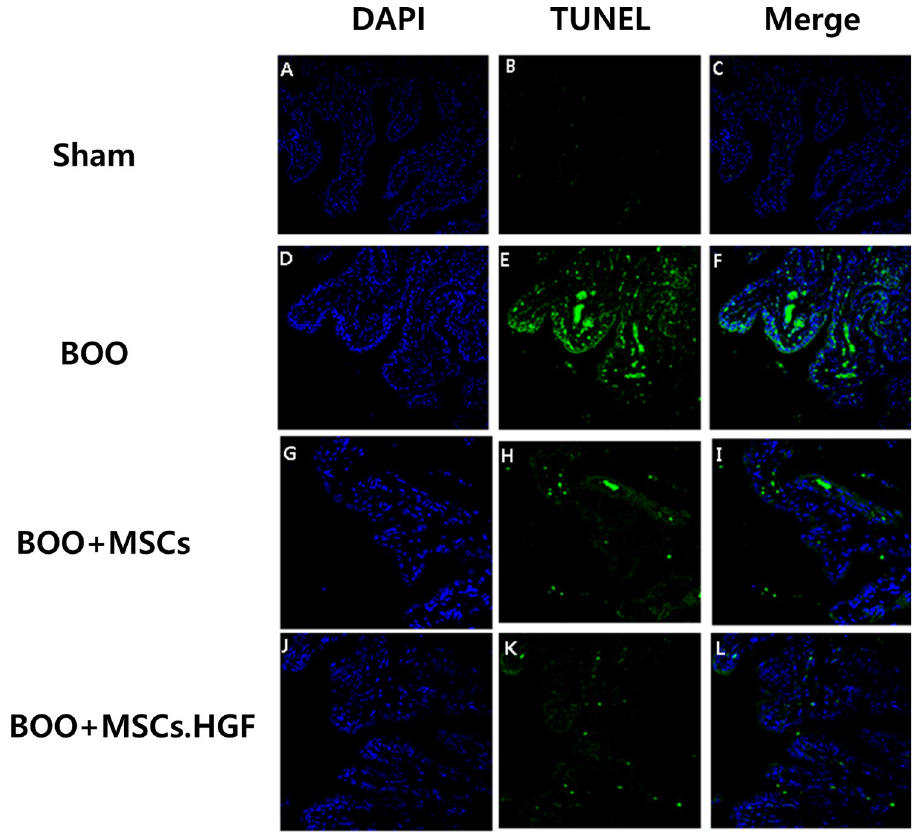
Fig 7. Immunofluorescent staining of bladder tissues. Staining with TUNEL led to increased TUNEL-positive apoptosis in the group of rats with BOO and decreased TUNEL-positive apoptosis after transplantation of hMSCs. The effect was enhanced by hMSCs.HGF. A-C. Sham operation group. D-F. BOO group. G-I. hMSCs transplantation after BOO. J-L. hMSCs.HGF transplantation after BOO. DAPI = 4’,6-diamidino-2-phenylindole, TUNEL = deoxynucleotidyl transferase-mediated dUTP nick end labeling, Sham = sham operation, BOO = bladder outlet obstruction, hMSCs = human mesenchymal stem cells, hMSCs.HGF = HGF overexpressing human mesenchymal stem